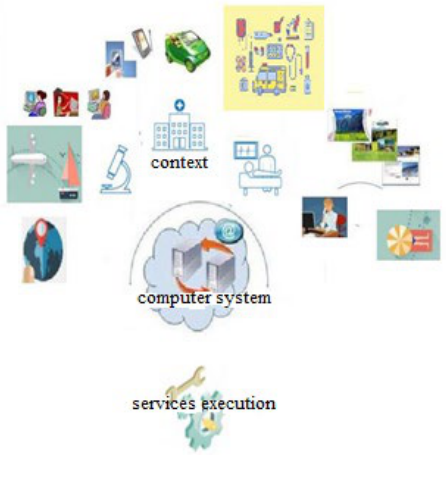
Figure 3 . Context diagram for the class is